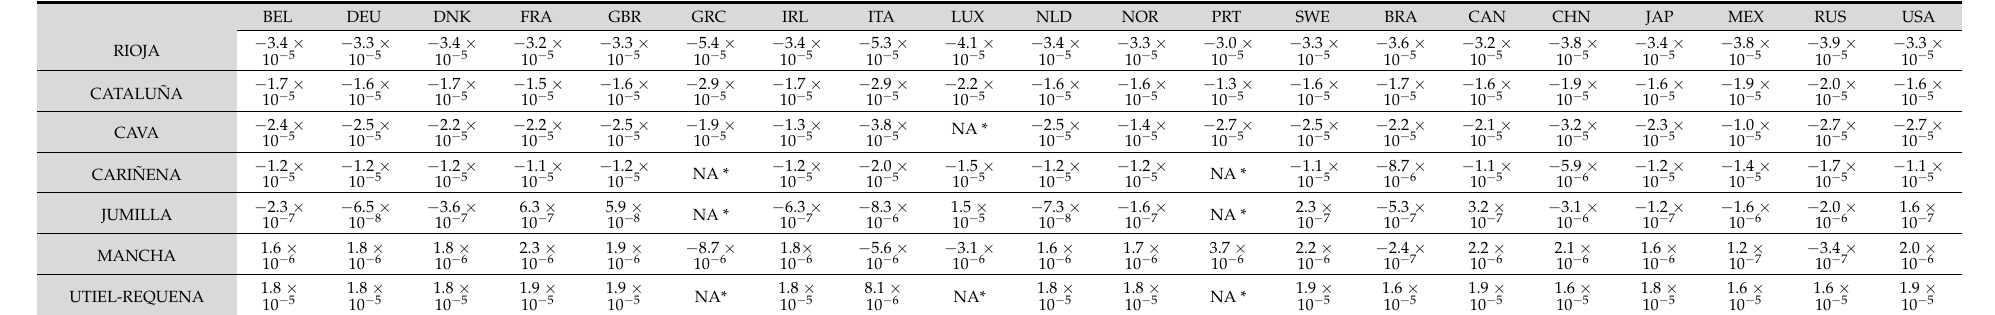
Table A1. Absolute variation in emissions per litre generated by Spanish DO wine exports (2005–2016). Source: Own preparation. * Non data